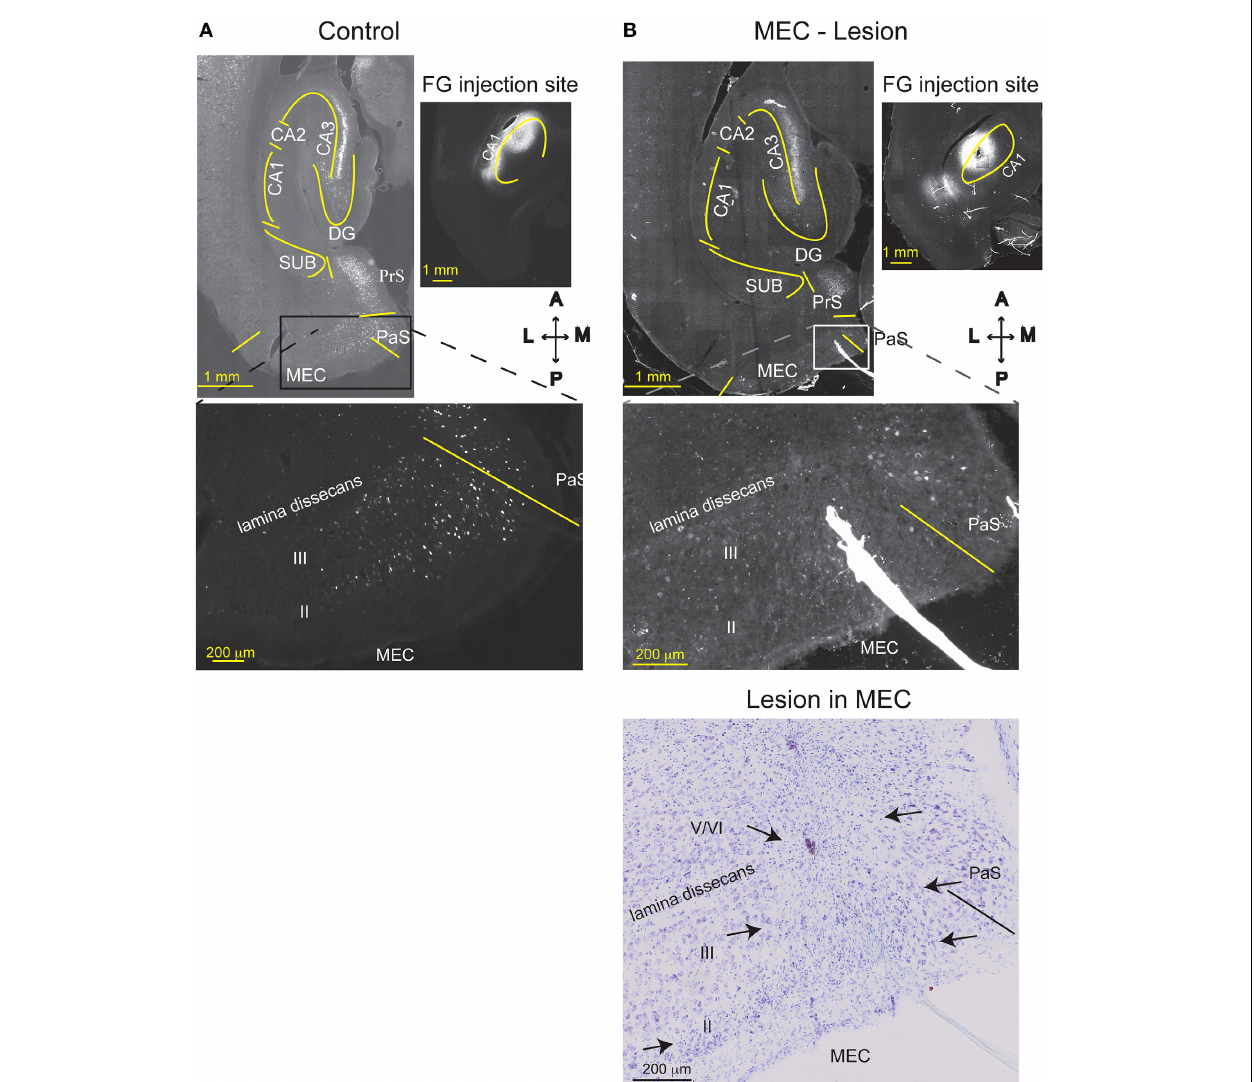
FIGURE 4 | MEC lesions were validated by loss of retrograde FG labeling. FG was injected into comparable levels of the dorsal CA1 of a TC animal (A) , or a MEC lesioned animal (B) one week after the lesion operation occurred. In the TC animal, MEC layer III and CA3 pyramidal cells were retrogradely labeled with FG, as expected. Strong labeling is also visible in the presubiculum (PrS). Creating an excitotoxic lesion in MEC, however, resulted in attenuated labeling of MEC layer III cells. As expected, cells in CA3 were still labeled, indicating